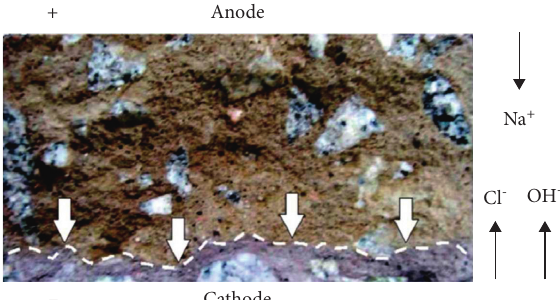
Figure 10: Colorimetric test of concrete with 50% fly ash (wide arrows indicate the precipitated chloride reaction front), repro- duced from [92], with permission from American Society of Civil Engineers,